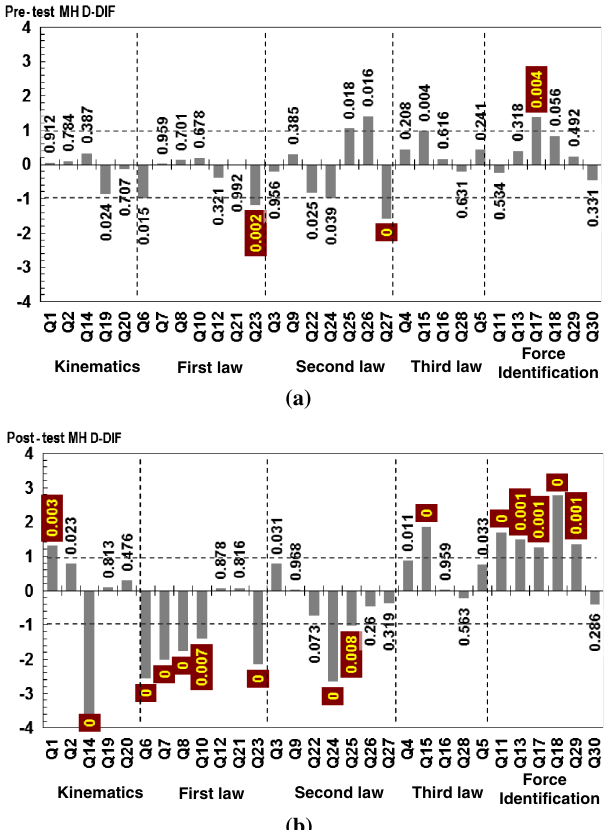
FIG. 3. MH D-DIF analysis. (a) MH D-DIF for pretest, (b) MH D-DIF for post-test. A positive MH D-DIF indicates an item in favor of the PRTC course; a negative MH D-DIF indicates an item in favor of the M&I course. The numerical value on top of each bar shows the corresponding significance level ( p value). Those with both j MH D-DIF j > 1 and p ≤ 0 . 01 are highlighted with color.